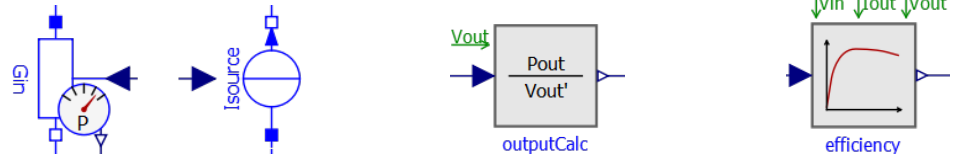
Figure 3. Icons of the components in the power path: input and output representation ( left ), determi- nation of output current ( middle ) and efficiency calculation ( right ).